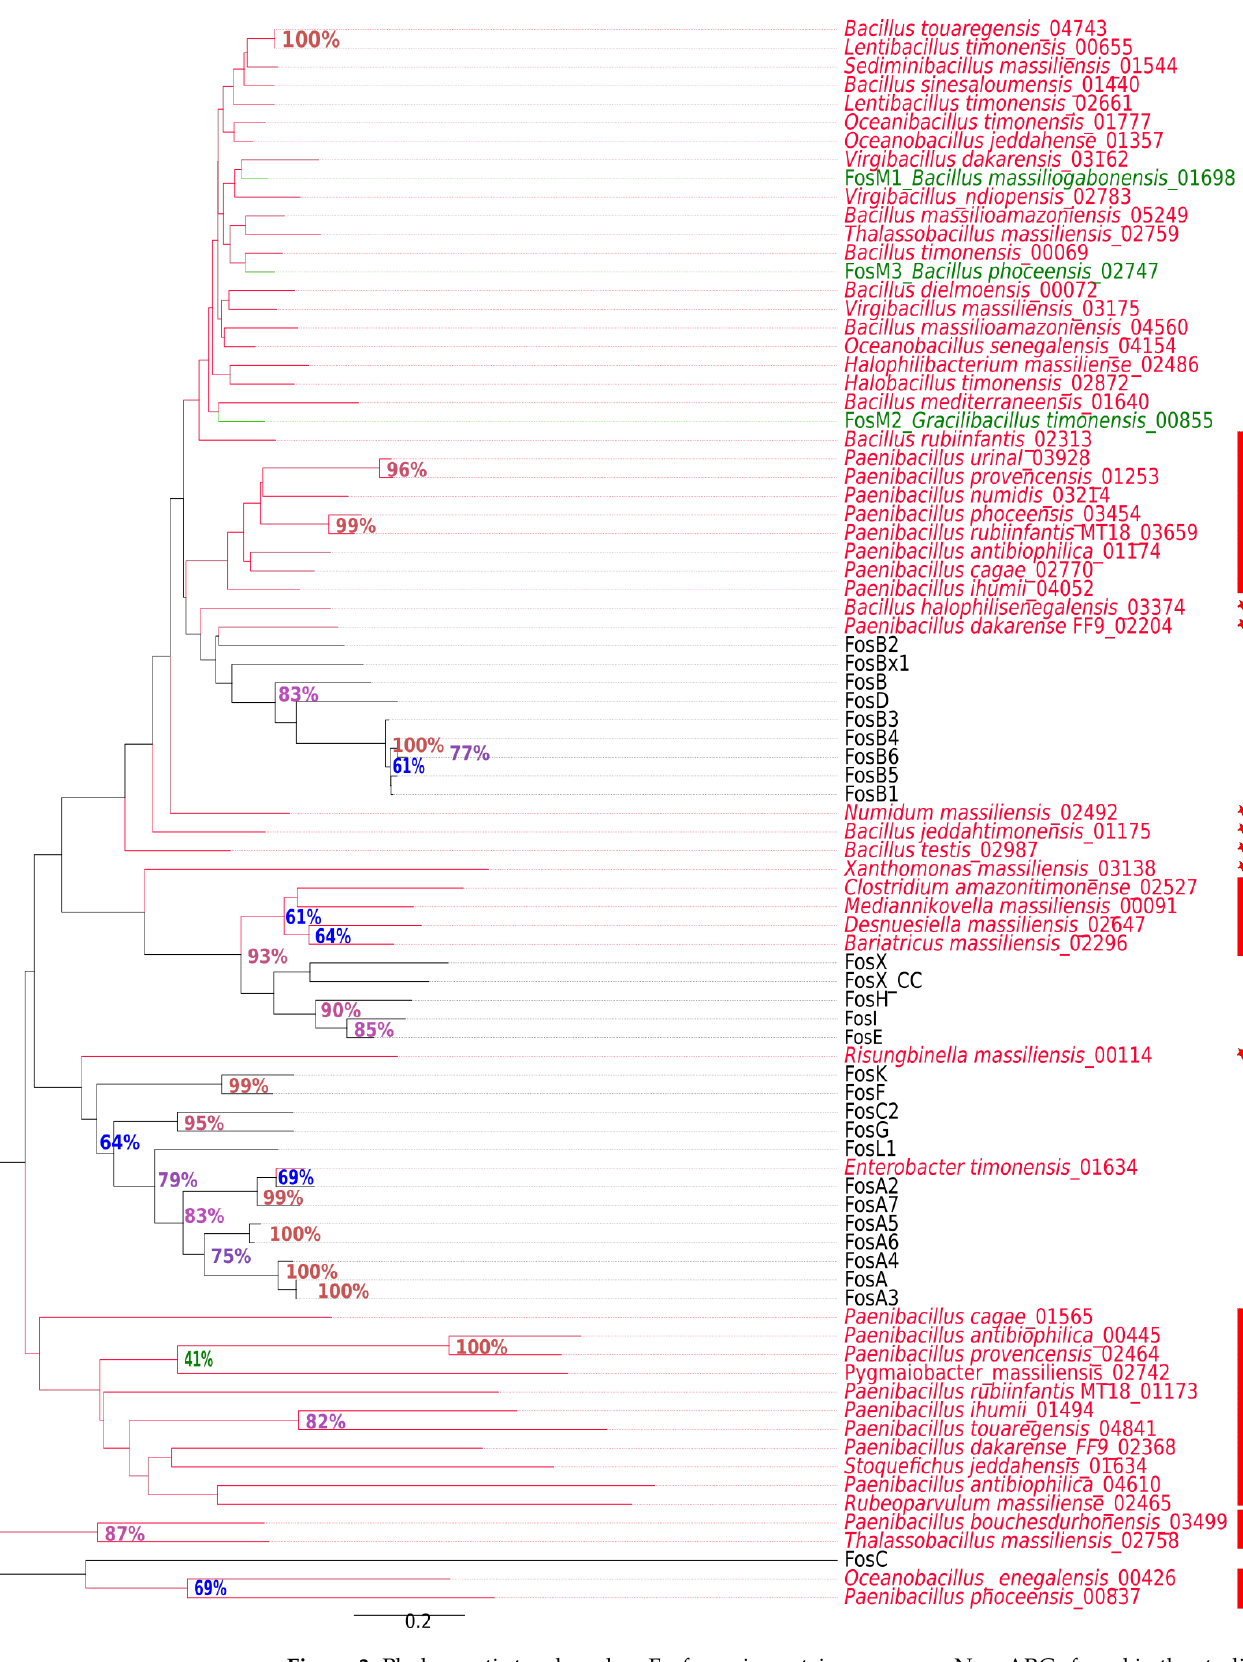
Figure 3. Phylogenetic tree based on Fosfomycin protein sequences. New ARGs found in the studied species are colored in red, stars indicate a new variant or new ARG-based one and a vertical bar indicates a new family of ARG. Green stars indicate genes that have been previously characterized biologically as fosfomycin resistance genes [32].